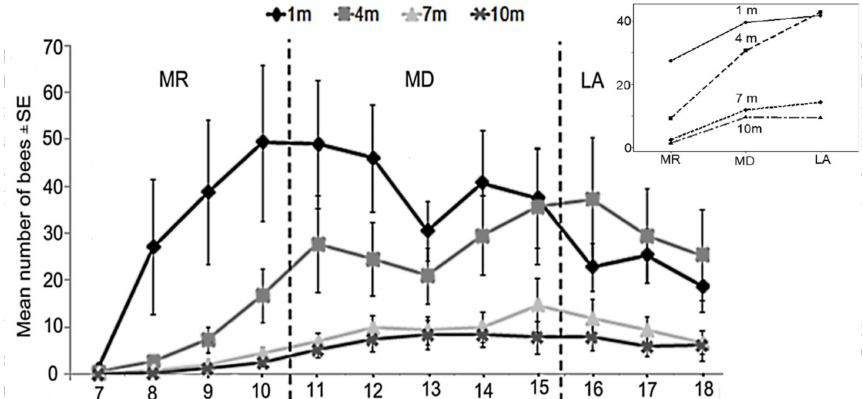
Figure 6. The mean number of Heterotrigona itama visited feeders at different distances (1 m, 4 m, 7 m, and 10 m). The time of visitation were categorized into: morning (MR, 7:00–10:40 h), midday (MD, 11:00–14:40 h), and late afternoon (15:00–18:40 h). Inset: The interaction plot of the mean number of bees visiting feeders at different distances across the three time